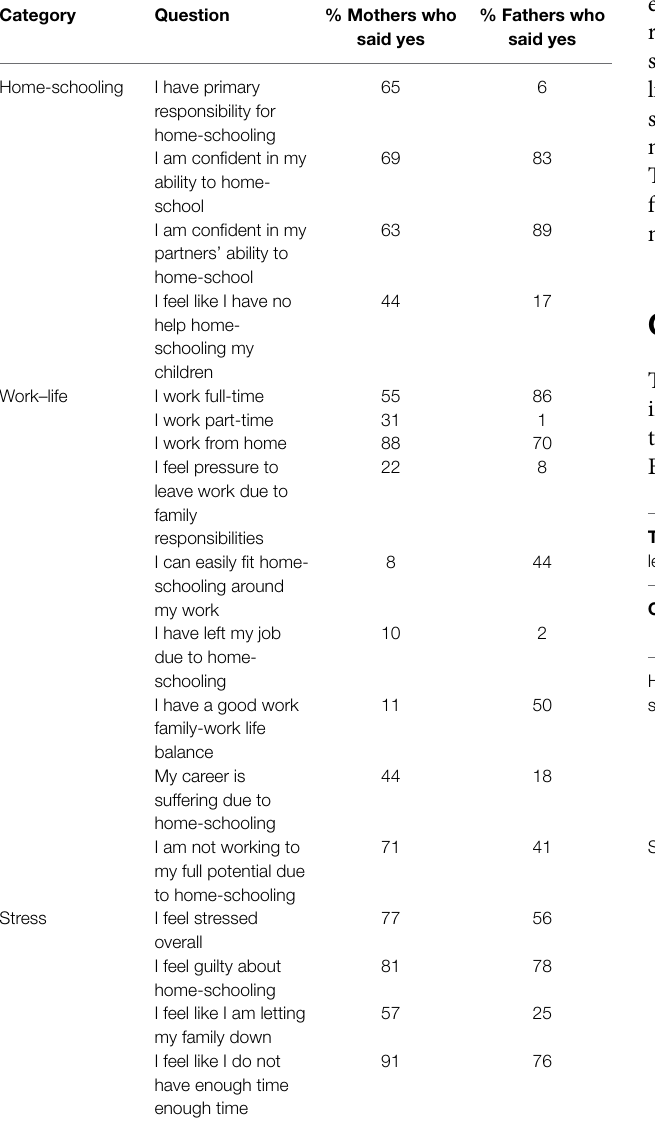
TABLE 1 | A comparison of the percentage of mothers and fathers who agreed with questions. Category